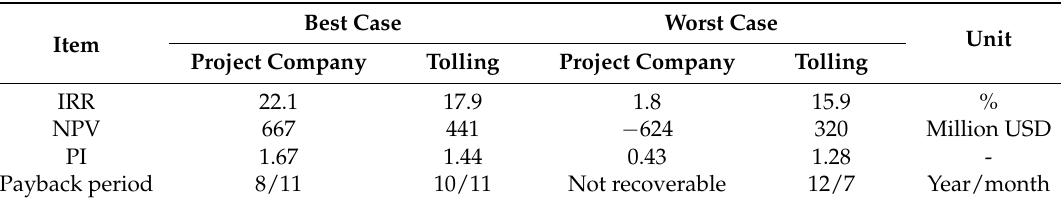
Table 13. Project C project company vs. tolling model economic